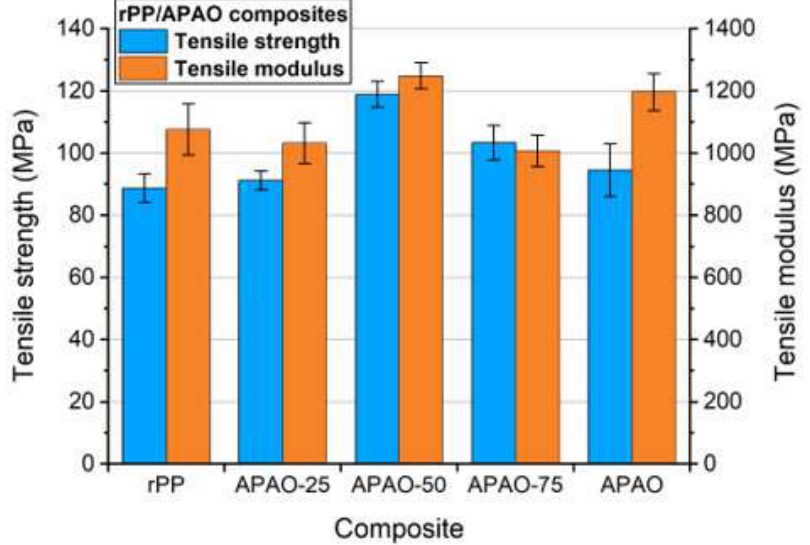
Figure 9. Maximal strength and tensile modulus values of the composites Figure 9 . Maximal strength and tensile modulus values of the composites